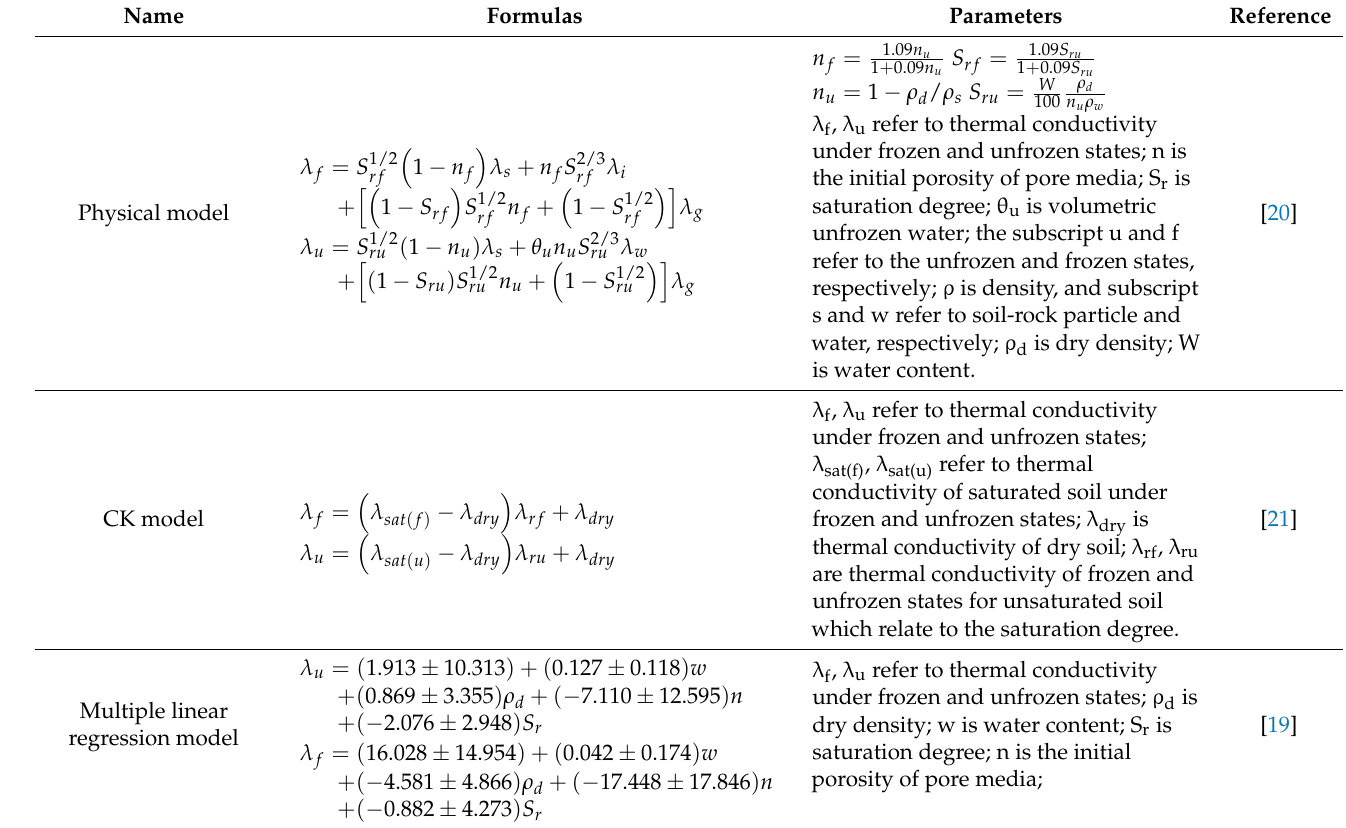
Table 1. Thermal conductivity